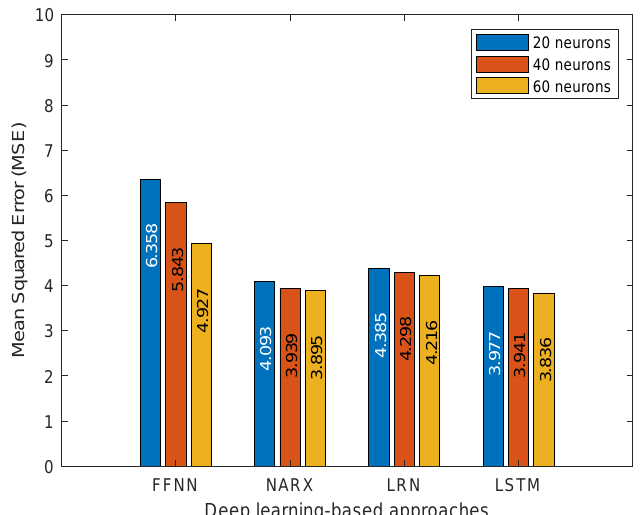
Figure 3. The MSE of deep learning-based approaches in the testing stage when the size of hidden layer is 20, 40, and 60 neurons,